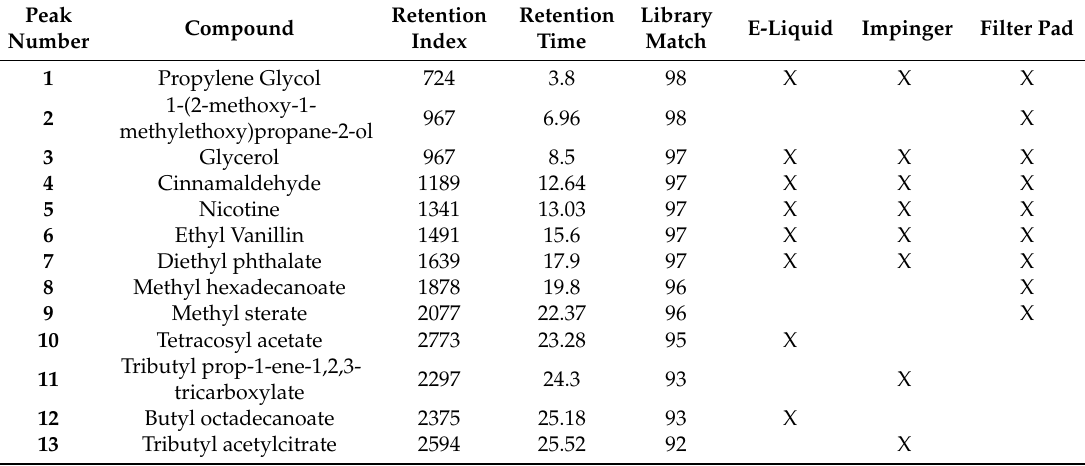
Table 4. GC-MS analysis of molecules in observed in aerosols generated from 100 puffs of cinnamon flavor e-liquid, in emissions captured with pads, and two series impingers.